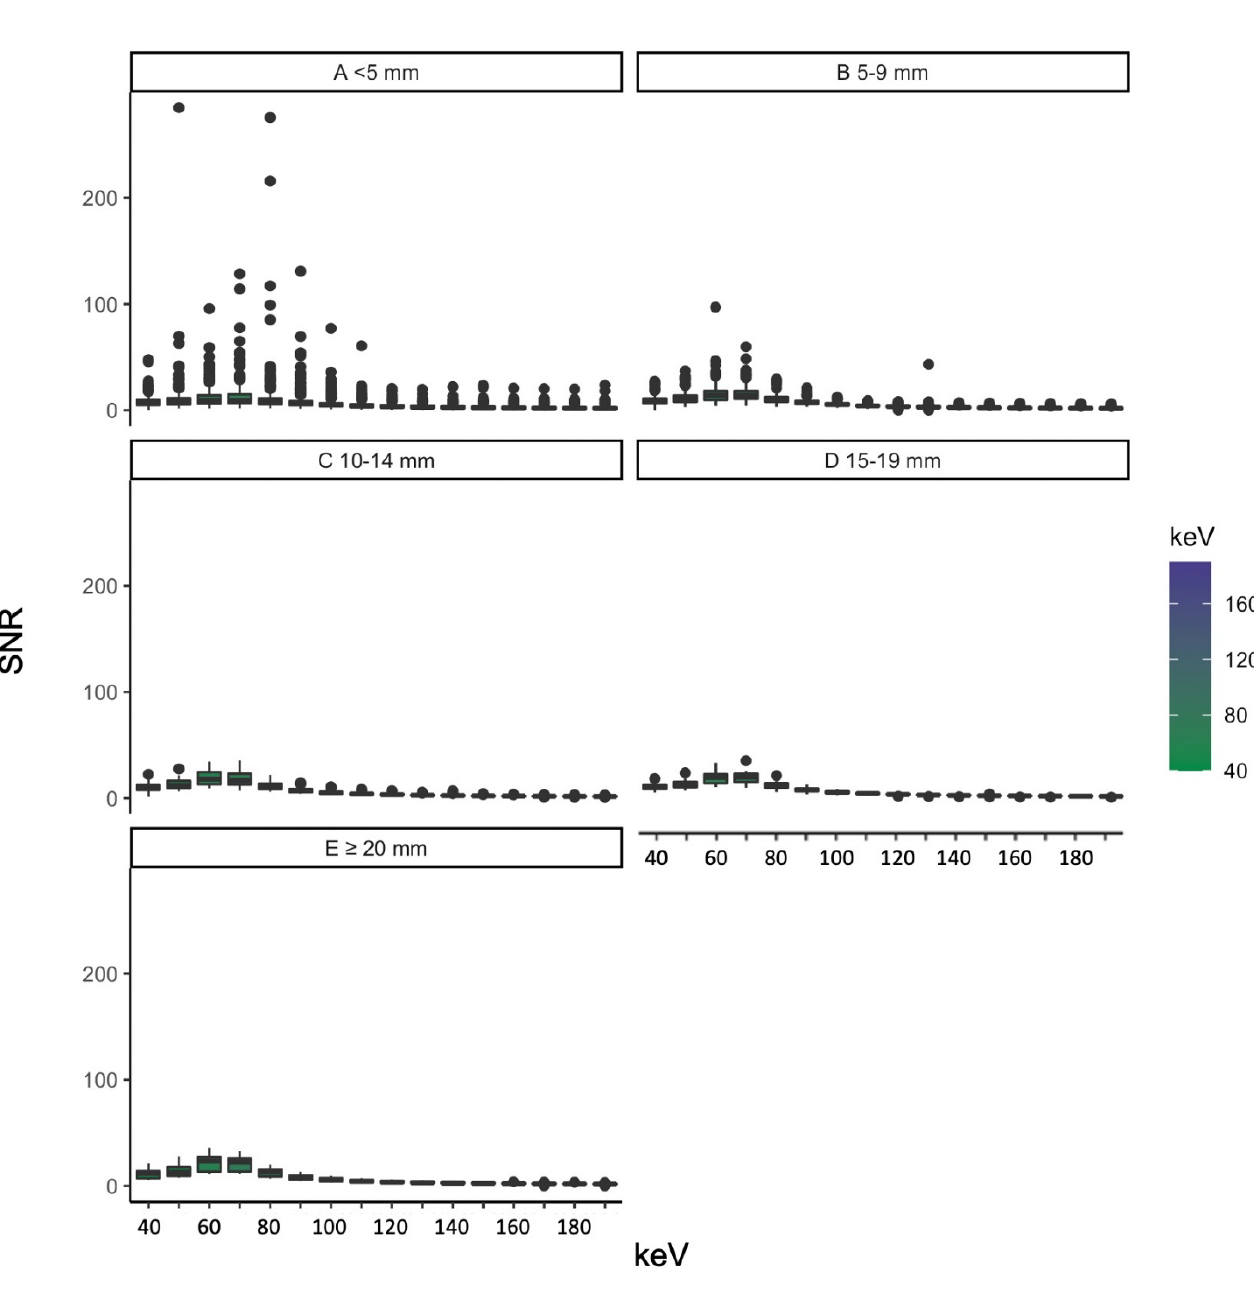
Figure 7. SNR grouped by vessel diameter (( A ) for less than 5 mm, ( B ) for 5–9 mm, ( C ) for 19–14 mm, ( D ) for 15–19 mm and ( E ) for more than 20 mm) at different energy levels.